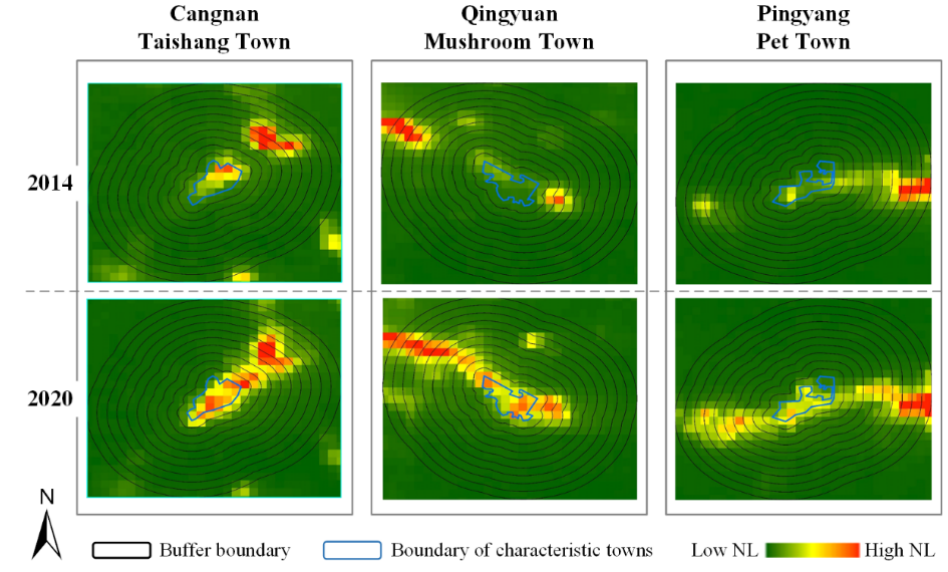
Figure 4. Spatial spillover scope of typical characteristic towns.